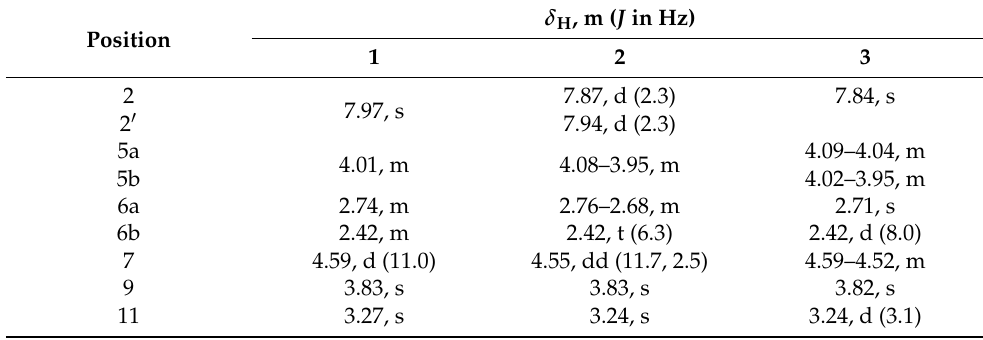
Table 1. 1 H-NMR spectroscopic data (600 MHz, DMSO- d 6 ) for purpuroines K–M ( 1 – 3 ).